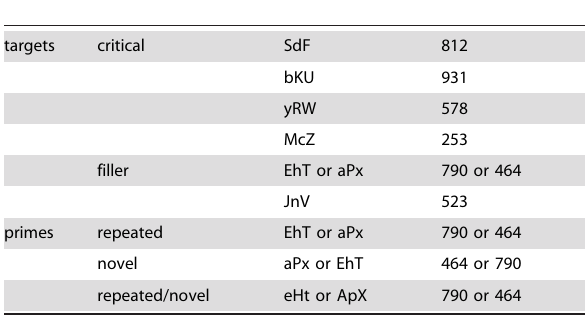
Table 1. Target and prime stimuli used in Experiment 2.